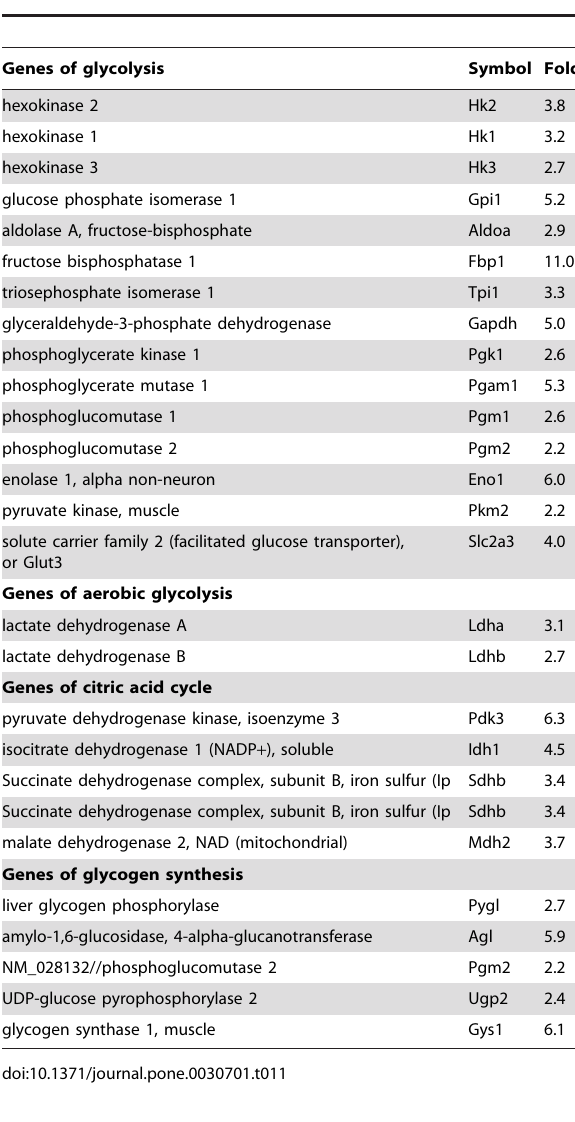
Table 11. Up-regulation of metabolic enzyme genes in glycolysis, citric acid cycle and glycogen syntheses in lal 2 / 2 bone marrow MDSCs.